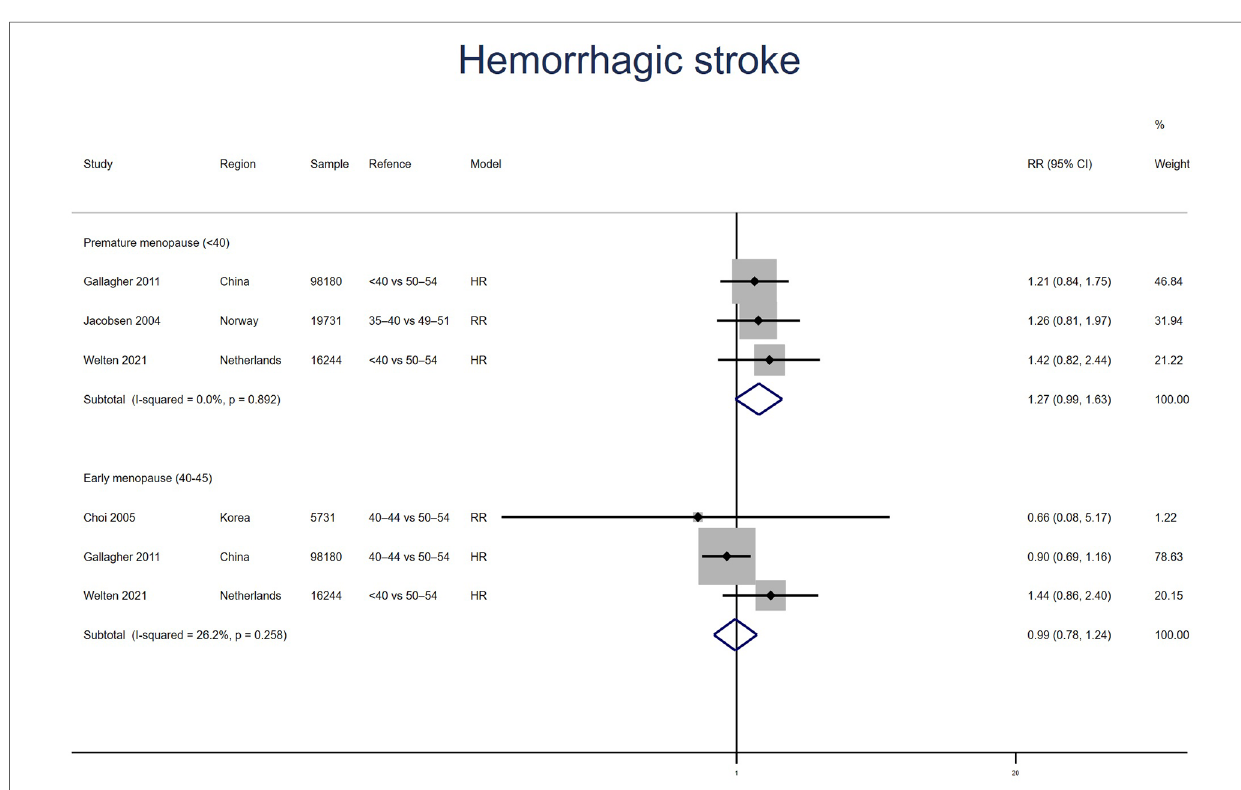
FIGURE 8 Forest plot presents the association between PM or EM and the risk of hemorrhagic stroke in cohort